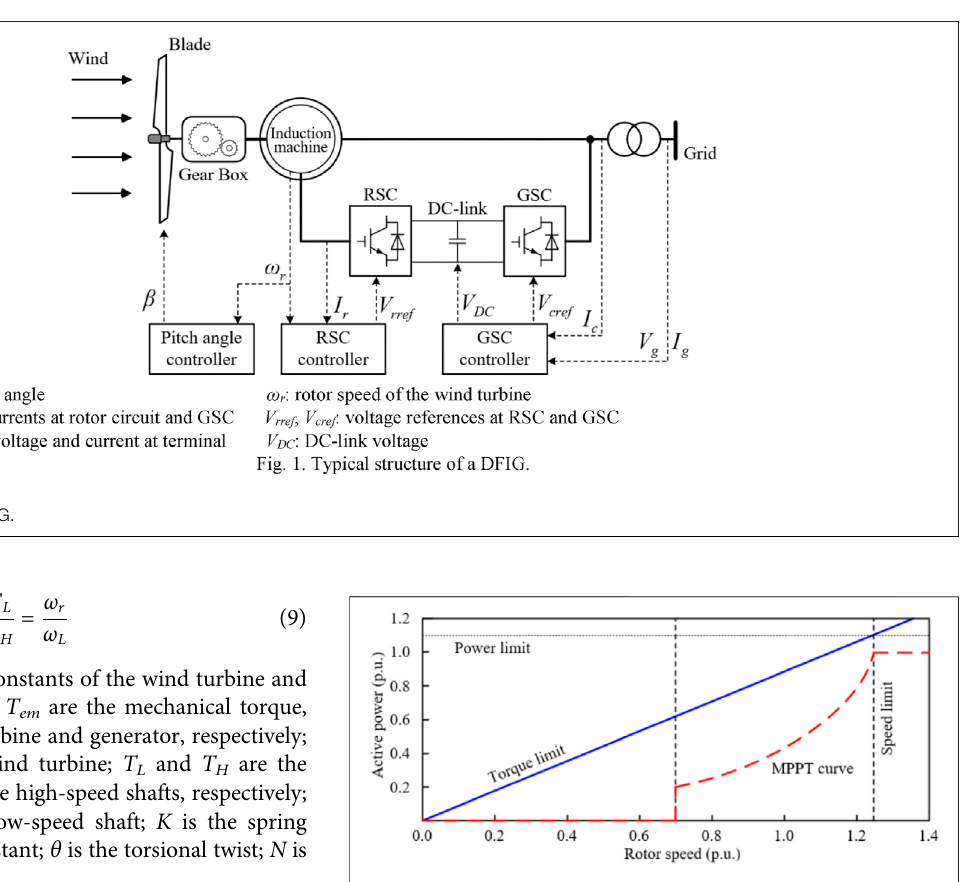
FIGURE 2 | Power characteristic curve of a